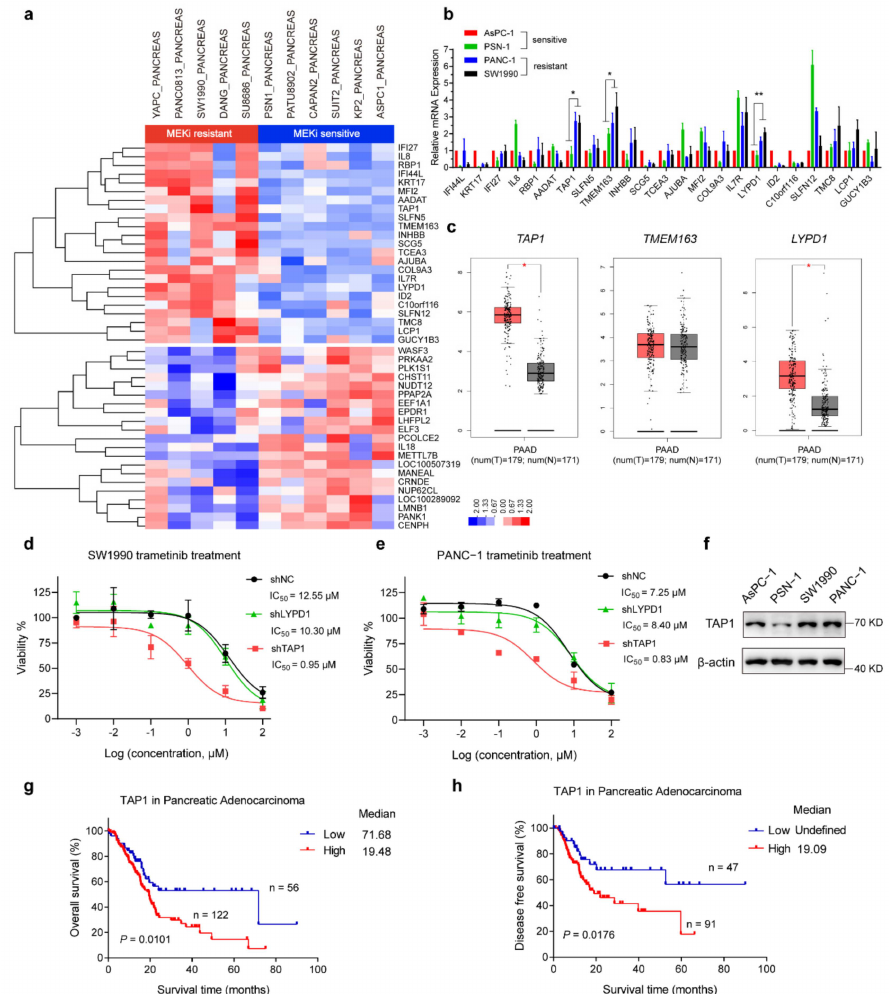
Figure 2. KRAS -mutant PDAC cell lines with high TAP1 are resistant to MEK inhibition. ( a ) Unsuper- vised hierarchical clustering of 11 KRAS -mutant pancreatic cancer cell lines from the CCLE database. Log2 transformed fold change expression levels are indicated by the color gradient. ( b ) The mRNA levels of 23 upregulation genes assessed by qRT-PCR in MEKi-resistant and -sensitive cell lines. * p < 0.05; ** p < 0.01; and one-way ANOVA test with Tukey’s multiple comparisons. ( c ) The mRNA expression levels of TAP1 , TMEM163 , and LYPD1 on box plots from GEPIA. Red color means tumor samples, n = 179; gray color means normal tissues, n = 171. One-way ANOVA analysis, * p < 0.05. ( d , e ) Trametinib sensitivity of SW1990 or PANC-1 cells with shTAP1 and shLYPD1 were determined by CellTiter-Lumi™ assays. Nontargeting shRNA (NC) was used as control ( f ) Western blot analysis of TAP1 expression in AsPC-1, PSN-1, SW1990, and PANC-1 cell lines. ( g , h ) Kaplan–Meier curve for overall survival and disease-free survival of the pancreatic adenocarcinoma patients based on the mRNA expression level of TAP1 from TCGA